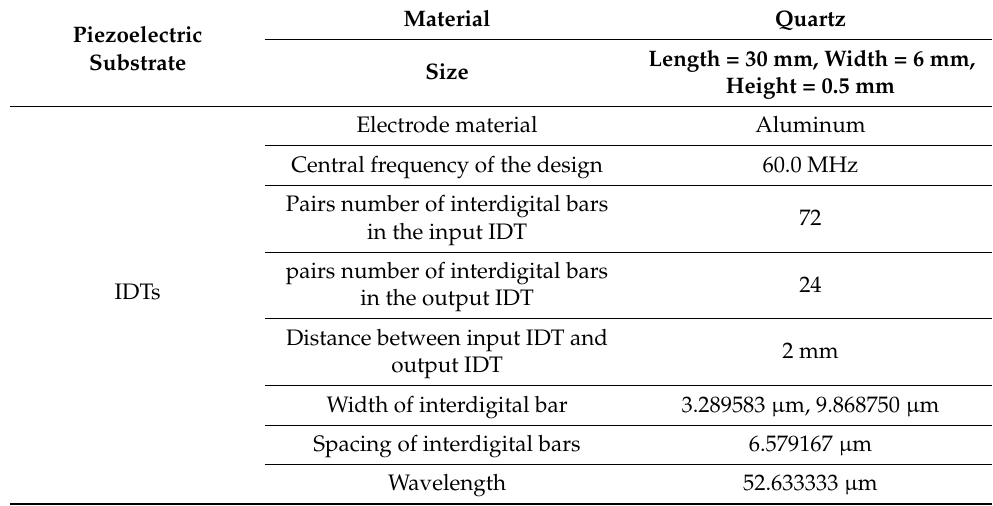
Table 1. The main design parameters of the simply supported beam SAW sensor.